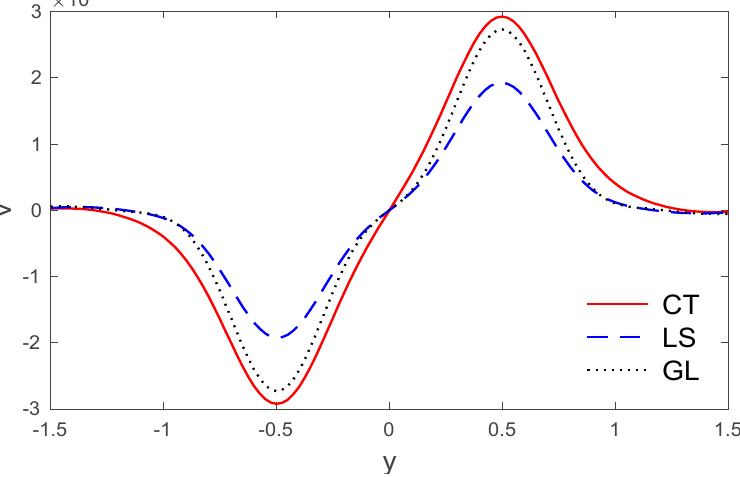
Figure 3. The variation of vertical displacement 𝑣 via 𝑦, with 𝑥 = 0.5 under the three models. The stress components 𝜎 (cid:3051)(cid:3051) and 𝜎 (cid:3051)(cid:3052) via 𝑦 are presented in Figures 4 and 5.